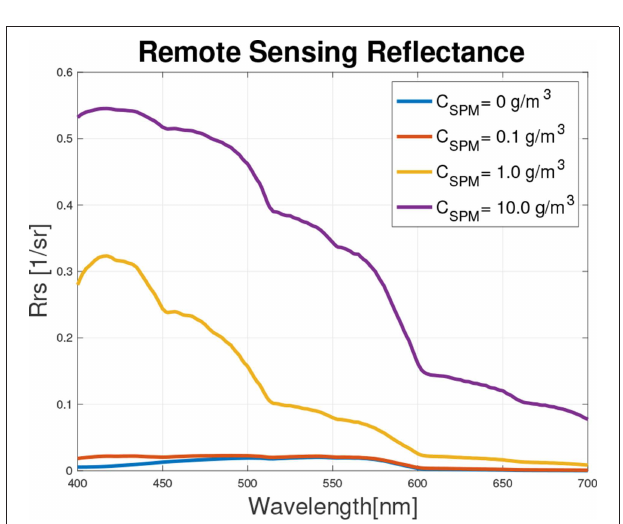
FIGURE 4 | Spectral remote sensing reflectance vs. wavelengths and SPM concentration, fixed grain size.